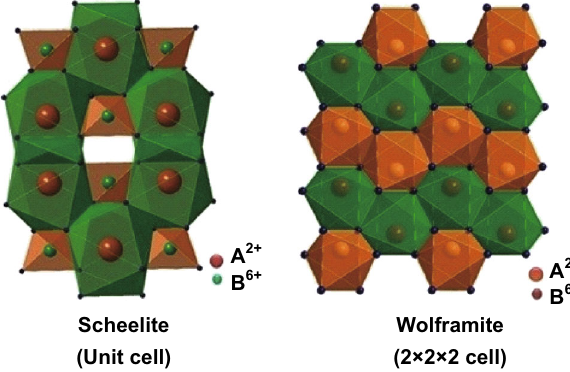
Scheelite (Unit cell) Fig. 2 Illustration of unit cells of scheelite and wolframite. Repro- duced with permission from Ref. [57]. Copyright 2014 Elsevier